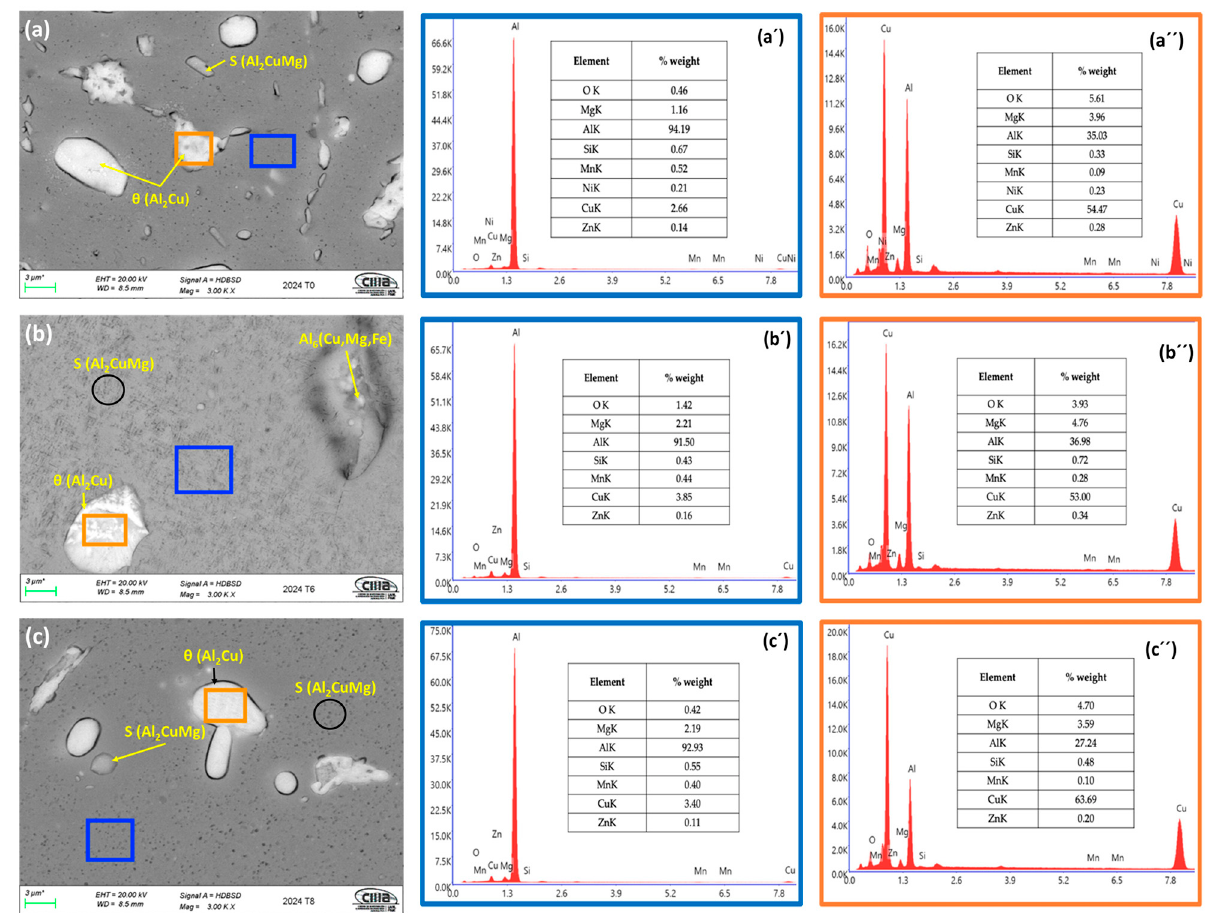
Figure 4. SEM-BSE micrographs of AA2024 alloy under ( a ) T0, ( b ) T6 and ( c ) T8 heat treatment conditions and EDS spectrum [T0 (a’, a’’), T6 (b’, b’’) and T8 (c’, c’’)].